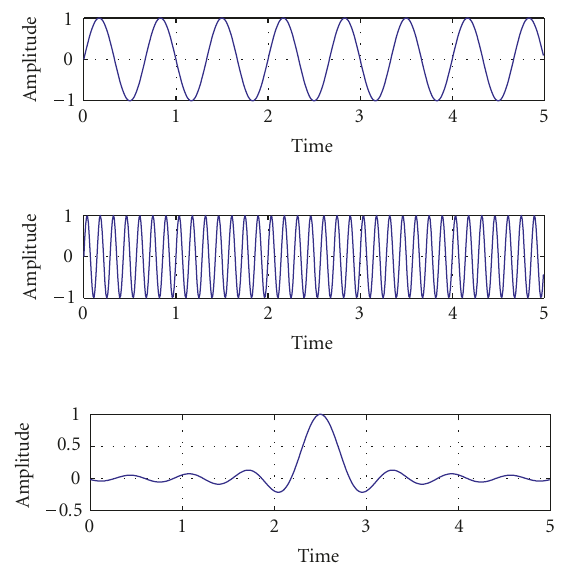
Figure 3: A set of synthetic sinusoidal sources with a sinc function emulating the P300 source.